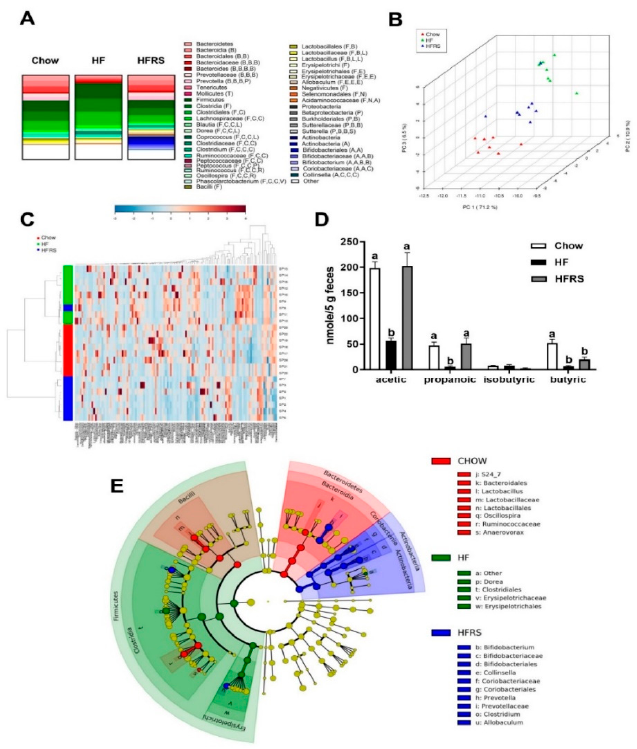
Figure 2. Potato RS improves microbiota dysbiosis. Microbiota abundance for chow, HF, and HFRS diet groups ( A ). The graph represents all abundances > 1% at all phylogenic levels. Phyla: B: